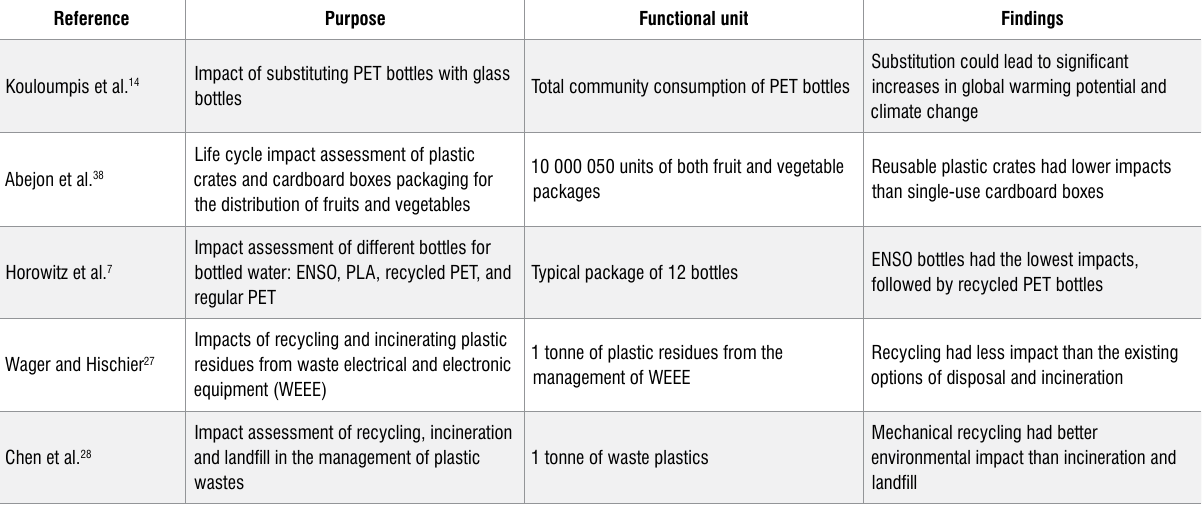
Table 1: Focus and findings of life cycle assessment studies on environmental impacts of plastic products